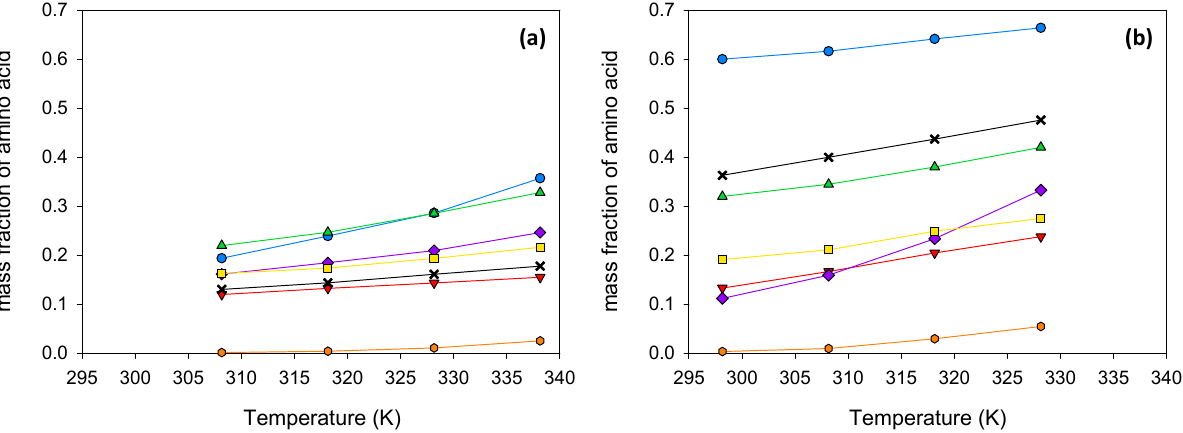
Figure 3. Solubilities of amino acids in the eutectic solvent ( a ) and in its 50:50 (wt:wt) mixture with water ( b ). Results are expressed as mass fraction. Legend: glycine; β -alanine; L-proline;